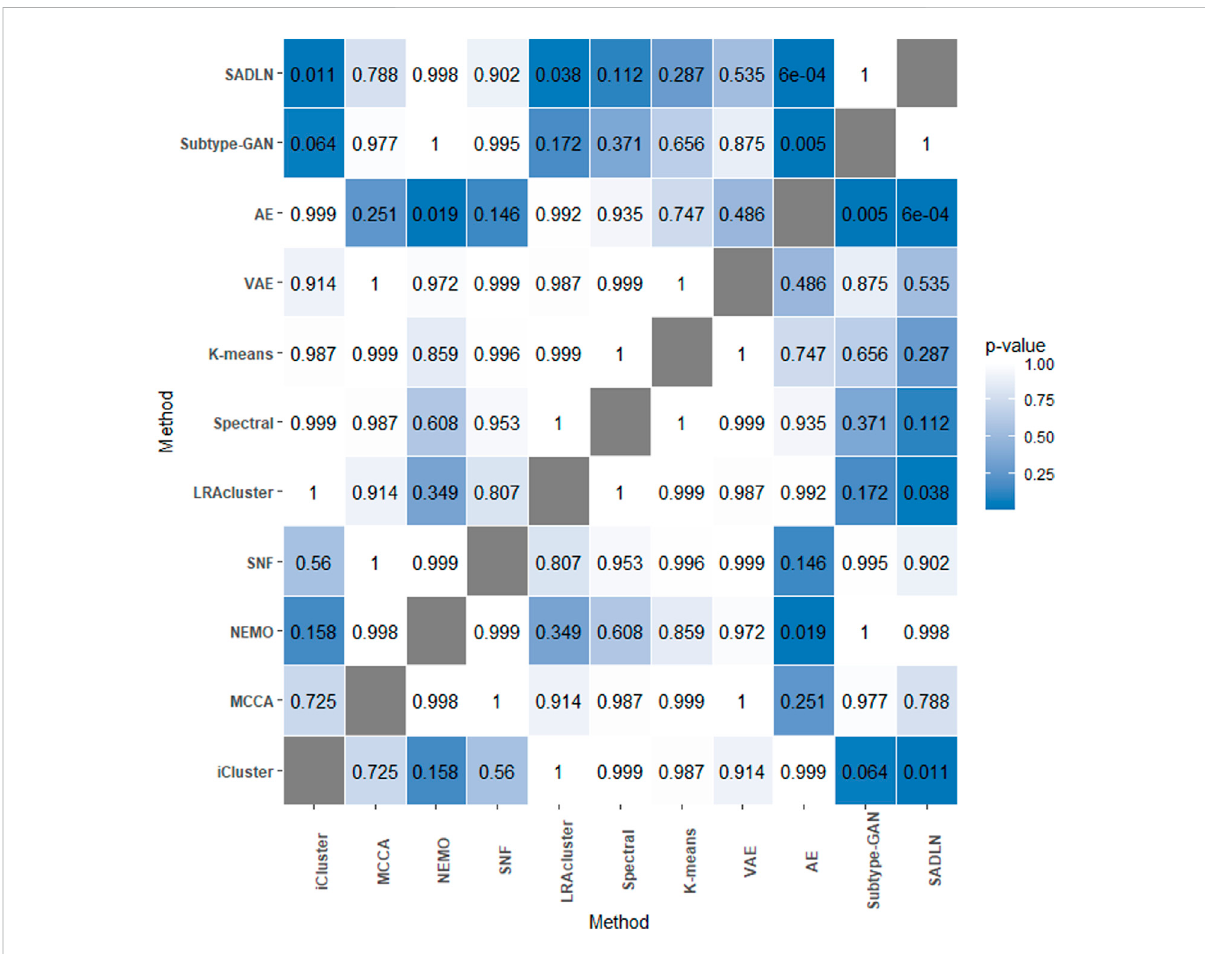
FIGURE 2 The p -values of the Friedman test on ten cancer datasets.